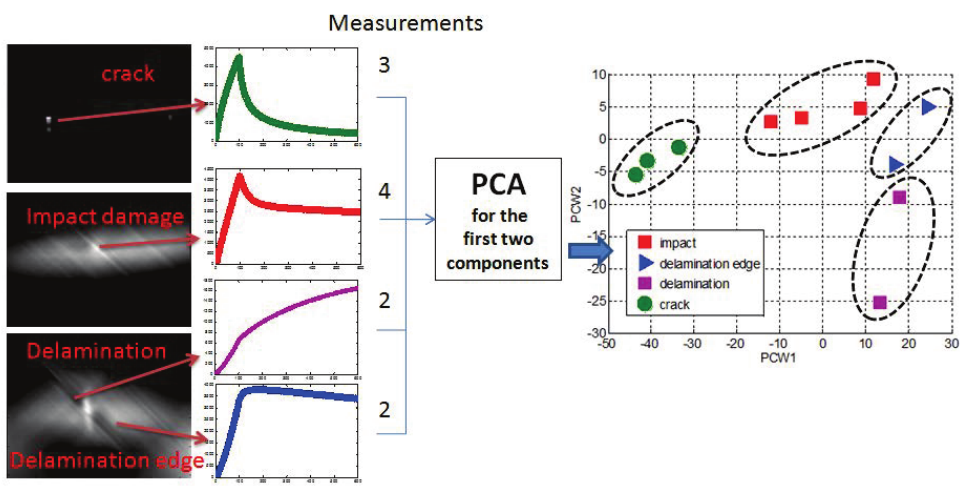
Figure 9. Principal component analysis (PCA) classification for cracks, impact damages and delaminations (Reproduced from [20] with